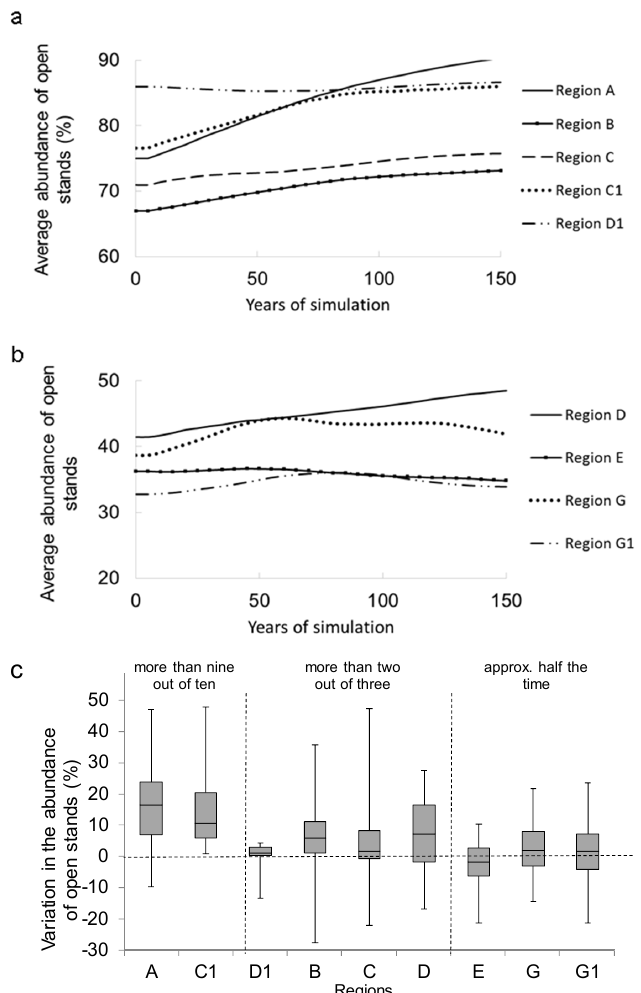
Figure 3. Dynamics of the average abundance of open stands in fire zones dominated by open stands ( a ); and in fire zones dominated by closed stands ( b ) with 100 simulations over 150 years of a forest succession model in interaction with natural disturbances. ( c ) Box and whisker plots representing the frequency distributions of the differences between final and initial abundances of open stands of 100 simulations over 150 years. Cumulative frequencies of positive changes were regrouped into frequency classes (more than nine out of ten: 0.90–0.99; more than two out of three: 0.66–0.90; and approximately half the time: 0.33–0.66).